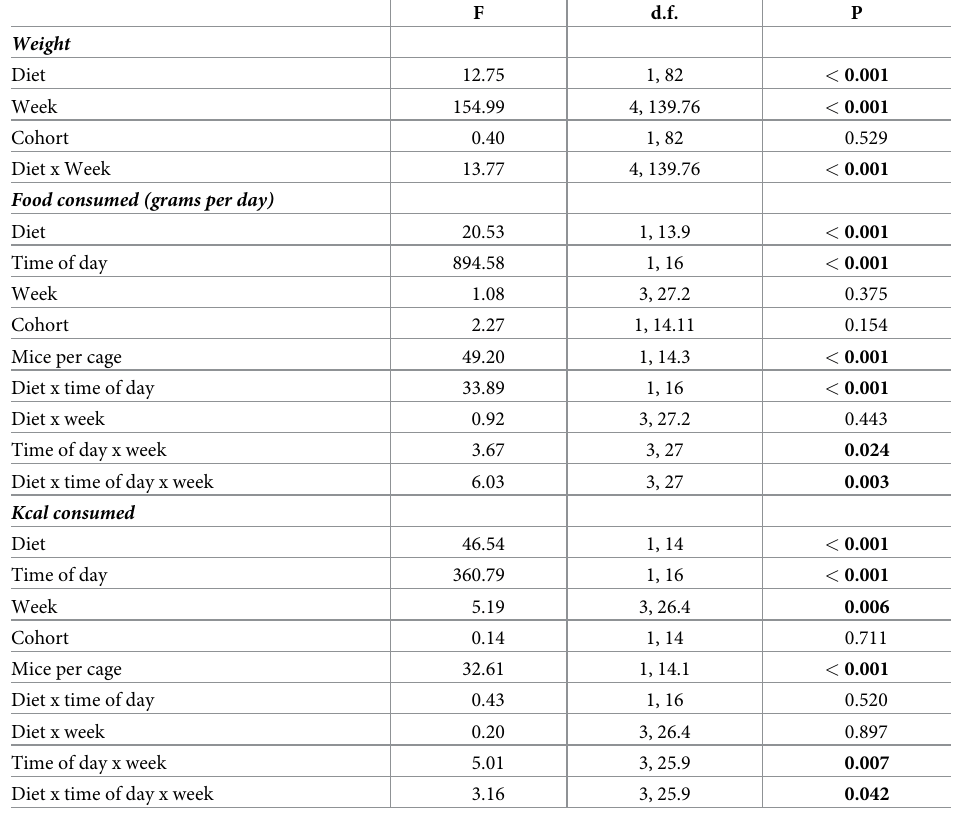
Significant results (P < 0.05) are marked in